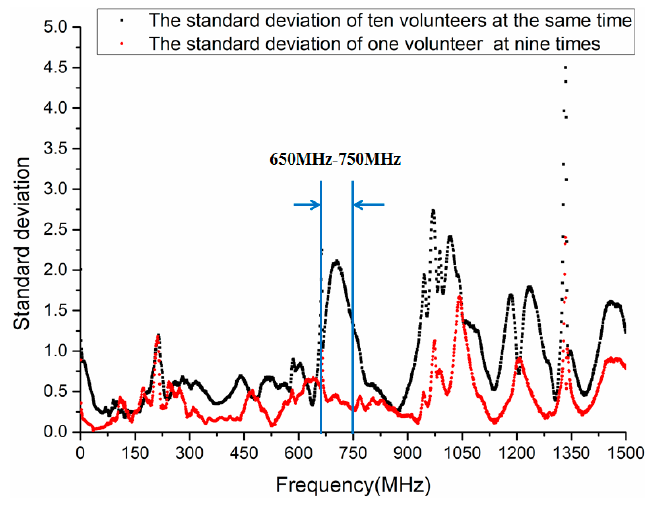
Figure 6. Standard deviation of transmission gain S21 in the frequency range 0.3 MHz to 1500 MHz.